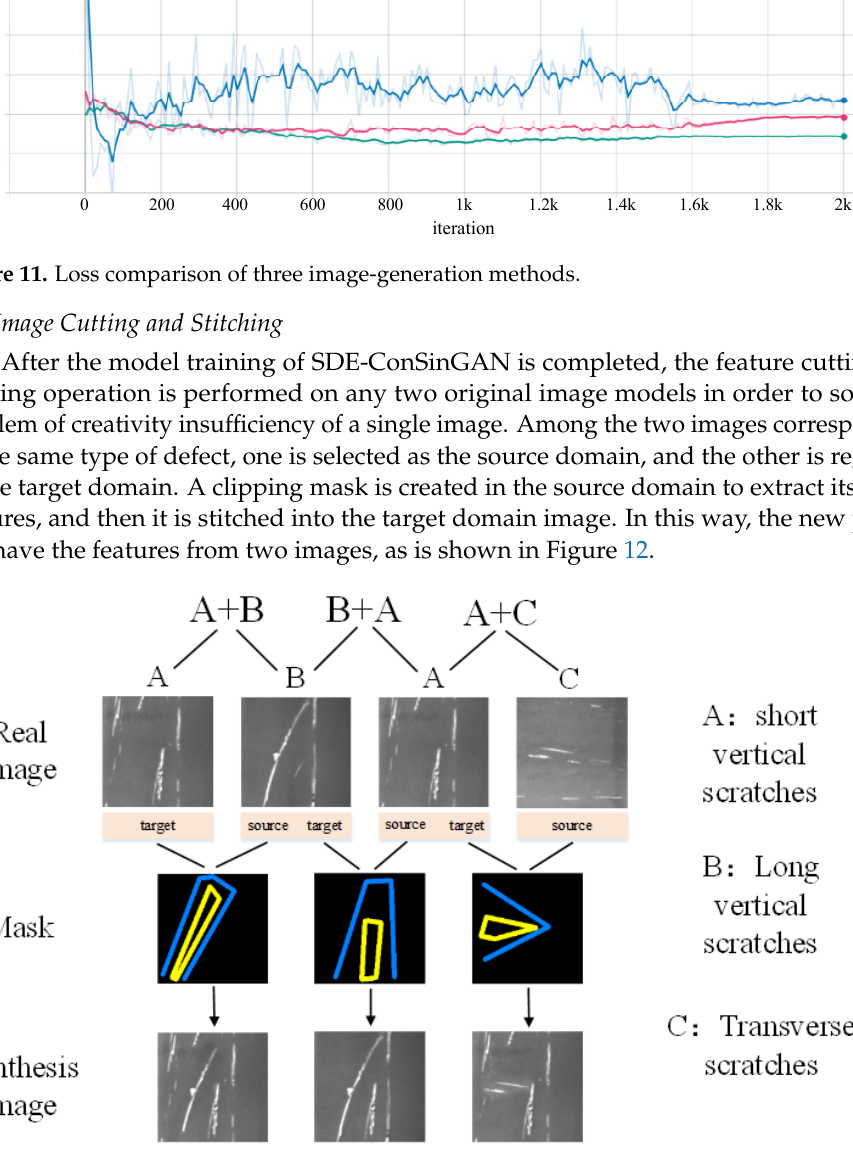
Figure 10. Defect image generation through various image-generation methods. ( a ) Sc. ( b ) In. ( c ) Pa. ( d ) Cr. ( e ) RS. ( f ) PS.